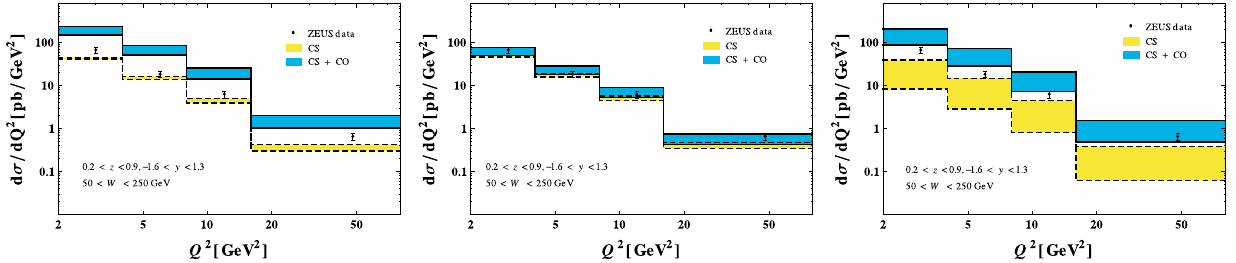
Fig. 7 The differential cross sections for the J /ψ production in DIS with respect to Q 2 . The experimental data are taken from Ref. [51]. The l.h.s., middle, and r.h.s. plots correspond to the LDMEs taken in Refs. [28,30,41], respectively